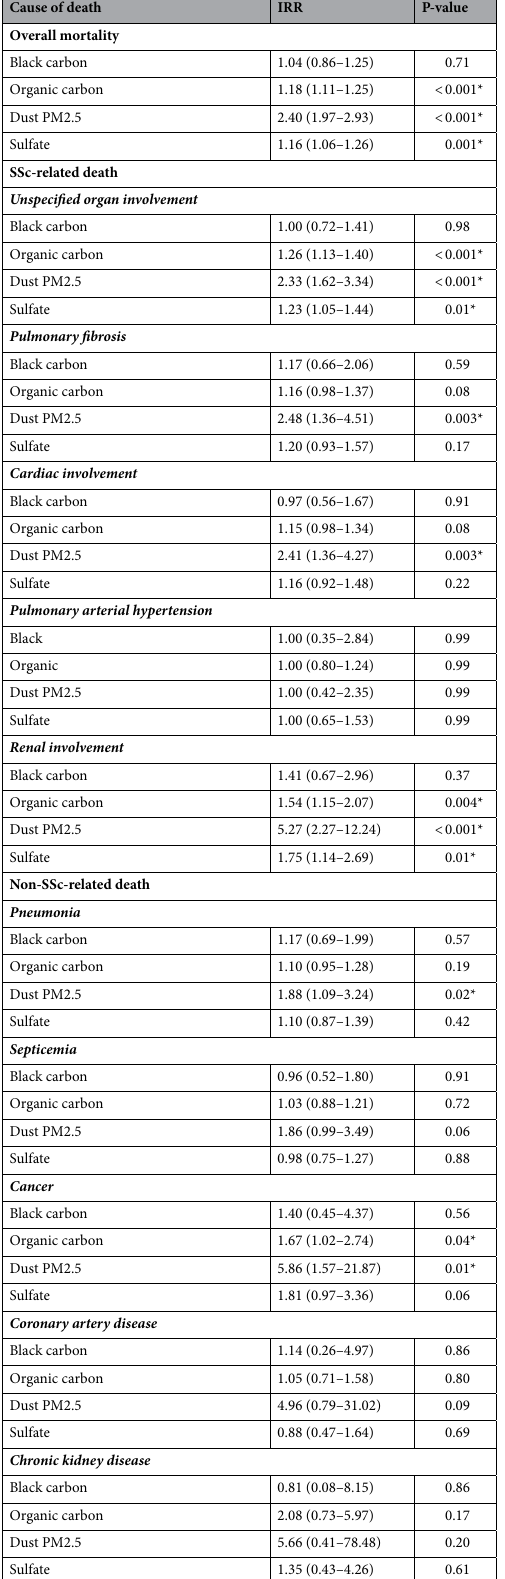
Table 3. Comparison of each cumulative aerosol component between 2014 and 2018 after adjusting for age, sex, and comorbid diseases-stratified by common causes of